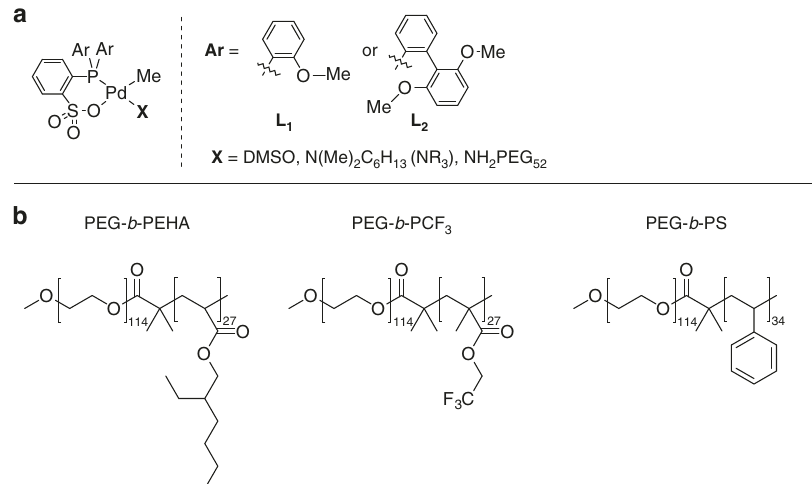
Fig. 2 Catalysts and block copolymers structure. a Catalysts: L 1 Pd-X and L 2 Pd-DMSO catalysts. b Block copolymers: PEG- b -PEHA, PEG- b -PCF 3 , PEG- b